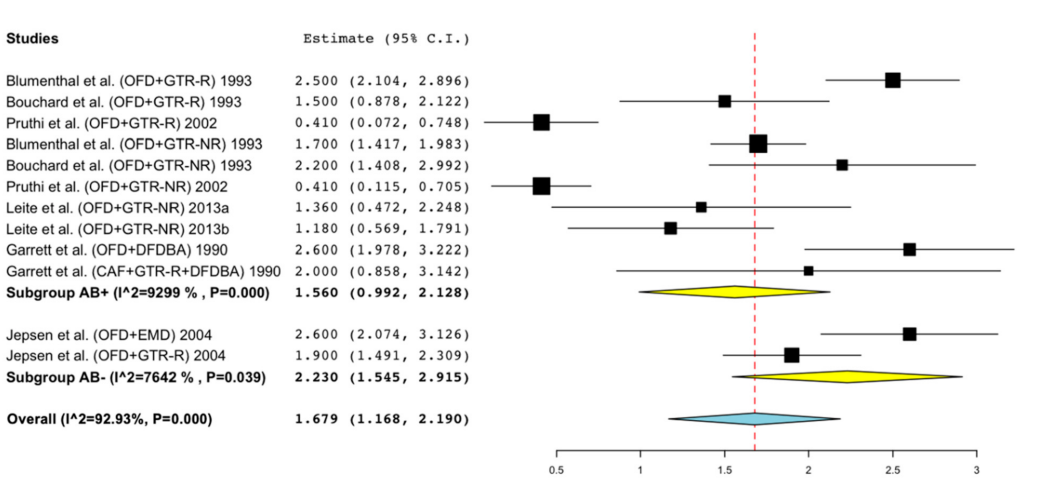
Figure 3. Forest plots of single-arm meta-analyses for H-BL gain for studies of regenerative techniques in furcation defects with or without adjunctive